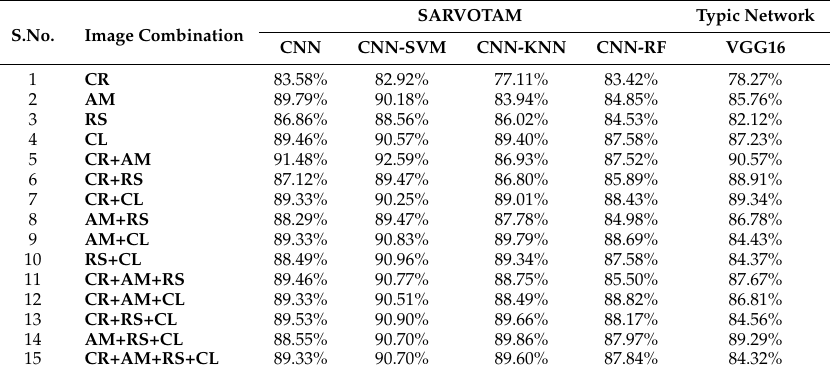
Table 8. Observed accuracy of SARVOTAM in comparison to VGG16 typic network.